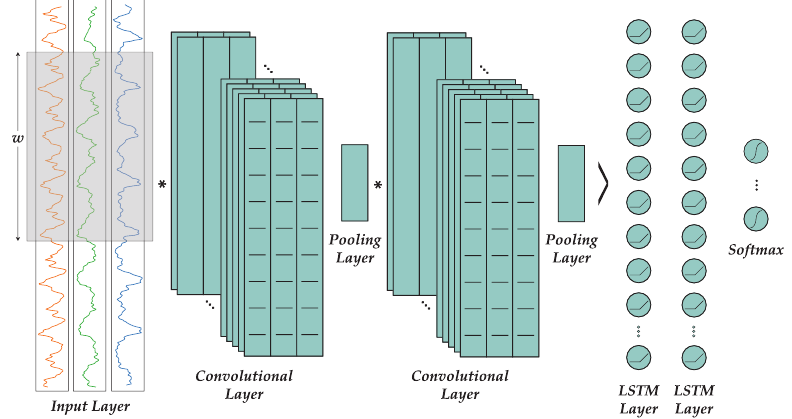
Figure 8. Convolutional neural network